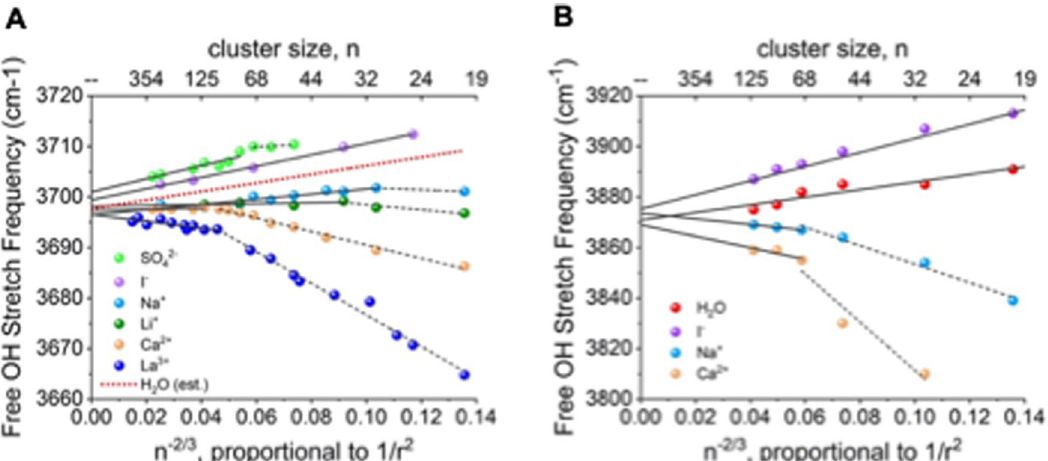
Fig. 1 Frequencies of the AAD free OH bands from spectra of (H 2 O) n and M(H 2 O) n . Here we compared experiments and theory for M = Ca 2 + , Na + , I − and Cl − as a function of n − 2/3 , which is proportional to 1/r 2 where r is the droplet radius. A Experimental results from IRPD spectroscopy; adapted with permission from the Royal Society of Chemistry 46 . B Results using the ReaxFF/CGeM force